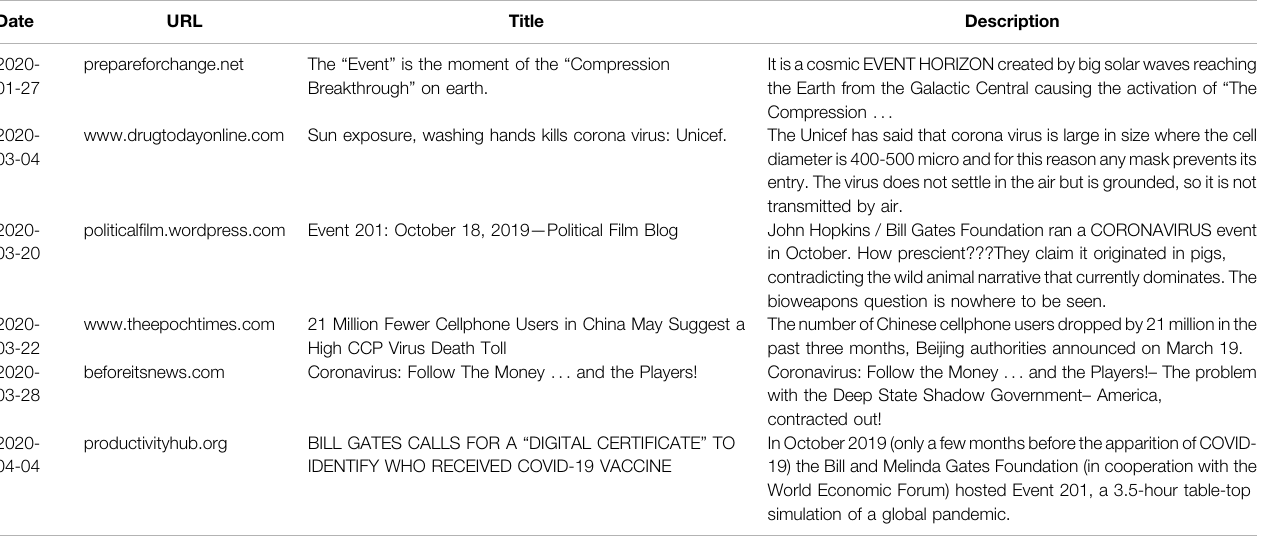
TABLE 7 | Example of fake news in our dataset. COVID-19 pandemic has resulted in misleading information, false claims, and pseudo-scienti fi c therapies, regarding the diagnosis,treatment, prevention, origin, andspread ofthevirus.Conspiracytheorieshave beenwidespreadtoo,mostlyonlinethroughblogs, forums,and